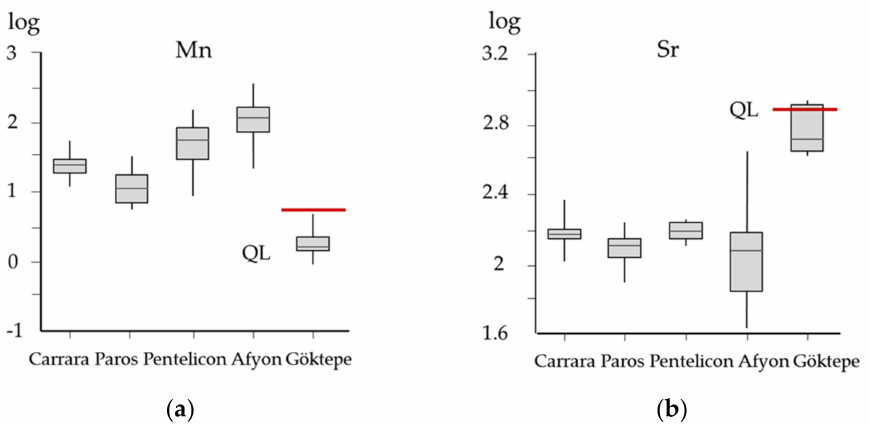
Figure 9. Box and whisker plots of Mn and Sr log-transformed concentration data from fine-grained marbles and the representation of the archaeological sample QL (red line), adapted from [25]. ( a ) Mn concentration; ( b ) Sr concentration.